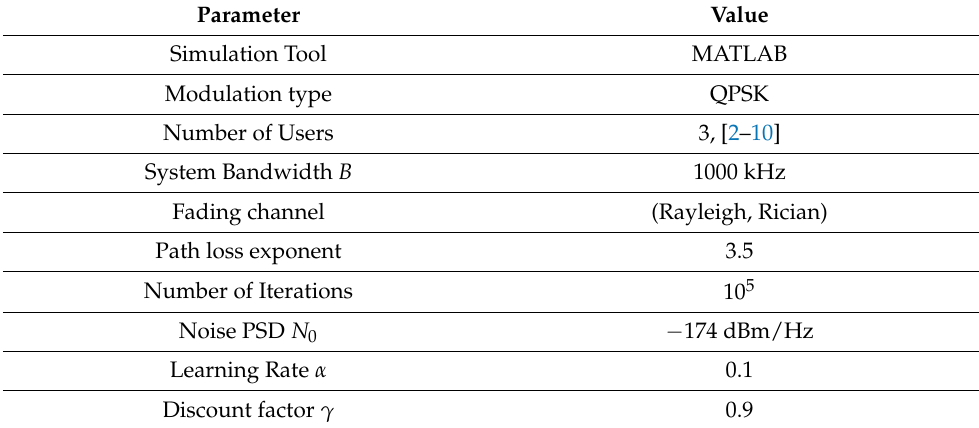
Table 1. Summary of Simulation